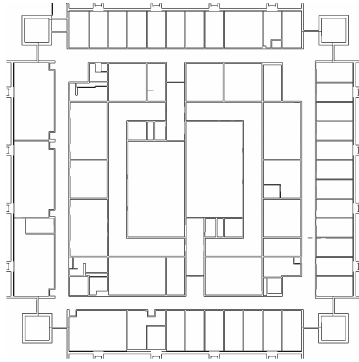
Figure 4. The floor plan for Petrie Science and Engineering Building at York University